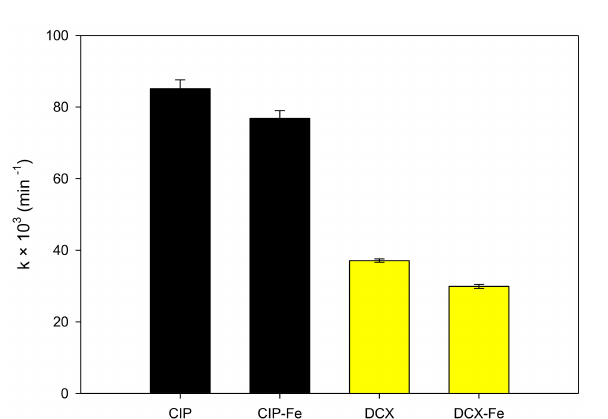
Figure 2. Pseudo-first order rate constants (k) for the degradation of the two representative an- tibiotics (CIP and DCX) and their ferric complexes by UVC irradiation. Experimental conditions: [CIP]: 5.0 µ mol L − 1 /[Fe (III)]: 2.5 µ mol L − 1 , [DCX]: 2.5 µ mol L − 1 /[Fe (III)]: 2.5 µ mol L − 1 ; pH initial 6.0.